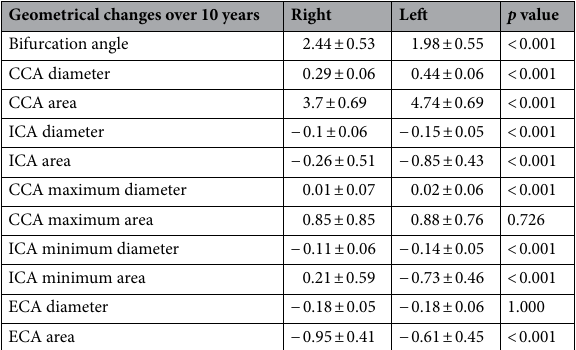
Table 3. Geometric changes in the left carotid artery from baseline and after 10 years of follow-up. CCA common carotid artery, ICA internal carotid artery, ECA external carotid artery.